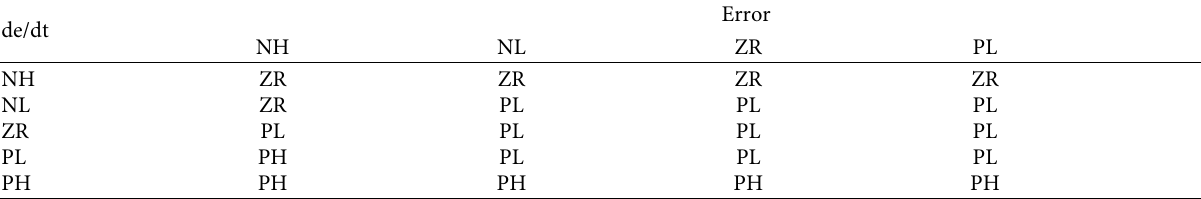
Table 3: If-then fuzzy logic rule base for ∆ k